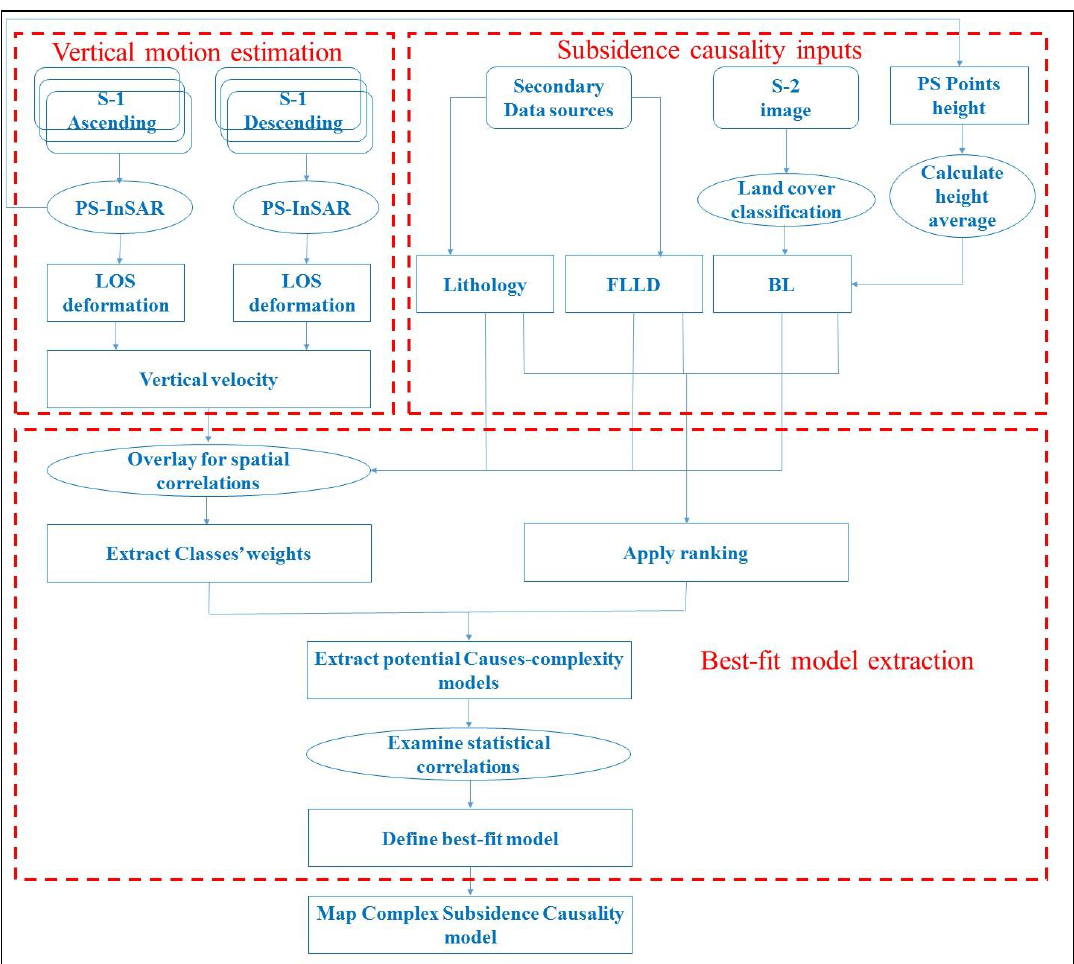
Figure 1. The workflow of the complex subsidence causality (CSC) model.